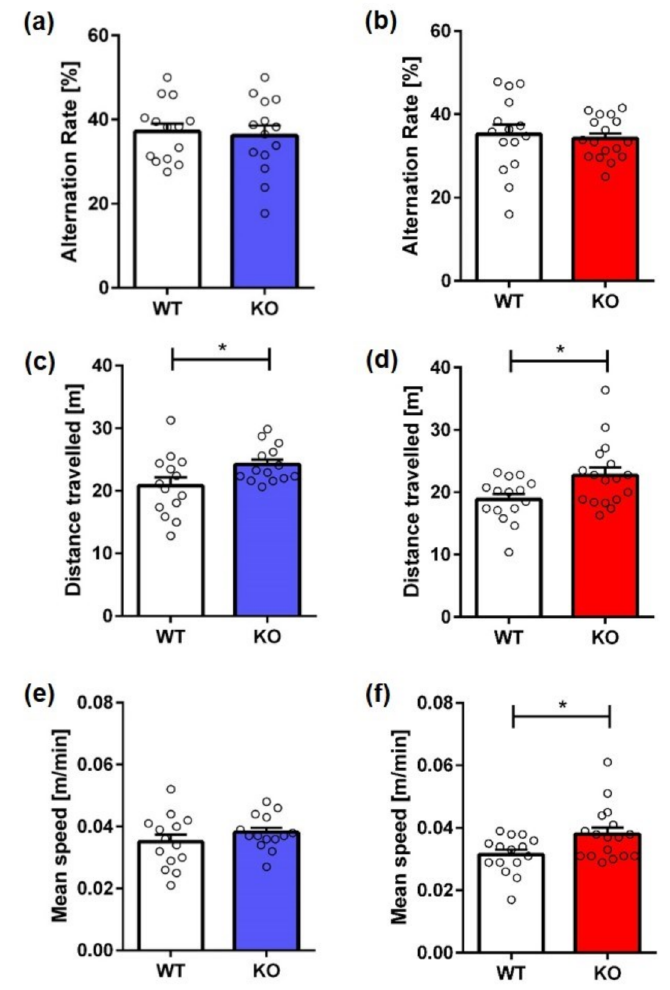
Figure 2. Working memory and exploration behavior of Mover KO mice in the cross maze. Spon- taneous alternation did not differ between male ( a ) or female ( b ) KO mice and same-sex WT animals. Male ( c ) and female ( d ) KO mice traveled significantly further than WT animals. In addition, female KO mice ( f ) showed an increased speed compared to WT mice. Mean speed did not differ between male KO mice and WT animals ( e ). Unpaired t -test, n = 15–17. Data presented as mean ± S.E.M. * p <